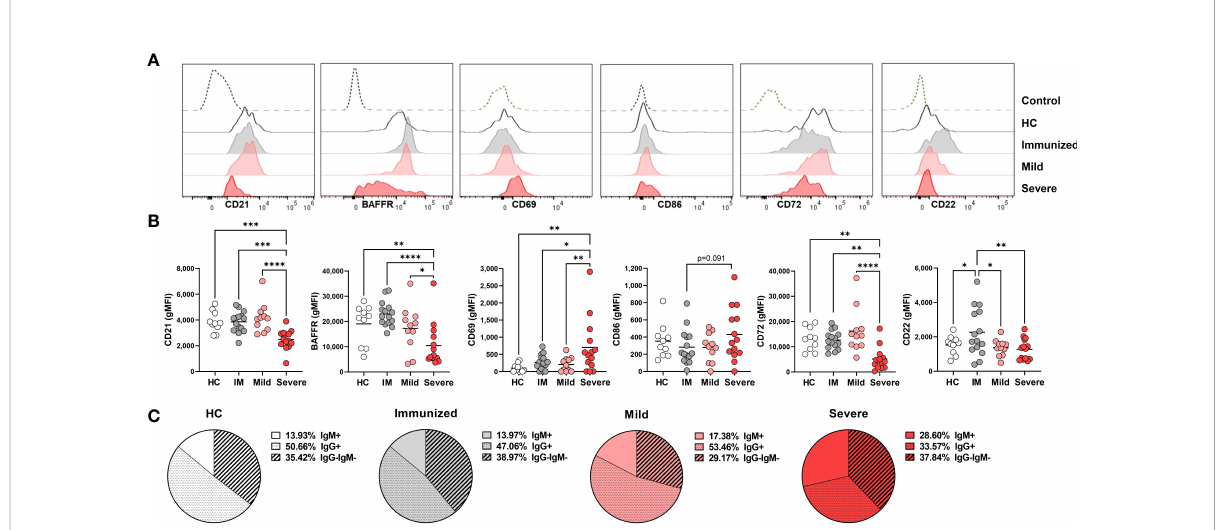
FIGURE 3 Phenotypic changes in DN1 cells with Severe SARS-CoV-2 infection. (A) Representative histograms depicting expression of CD21, BAFFR CD69, CD86, CD72, and CD22 on DN1 cells from a healthy control (HC), an individual immunized against SARS-CoV-2 or with mild or severe SARS- CoV-2 infection. Control dotted histogram is an FMO for CD69, CD68, CD72 and CD22. Control dotted histogram for BAFFR and CD21 is expression on CD3+ T cells from a healthy control subject. (B) Quanti fi cation of CD21, BAFFR, CD69, CD86, CD72, and CD22 expression (gMFI: geometric mean fl uorescent intensity) on DN1 cells from healthy controls (HC), individuals immunized against SARS-CoV-2 (IM), or with mild or severe SARS-CoV-2 infection. (C) Pie charts depicting the average frequency of IgM+, IgG+, or IgG-IgM- DN1 cells for healthy controls (HC, N=10), individuals immunized against SARS-CoV-2 (N=15), or with mild (N=11) or severe SARS-CoV-2 infection (N=14). Statistics: one-way ANOVA, *p < 0.05, **p < 0.01, ***p < 0.001, ****p <